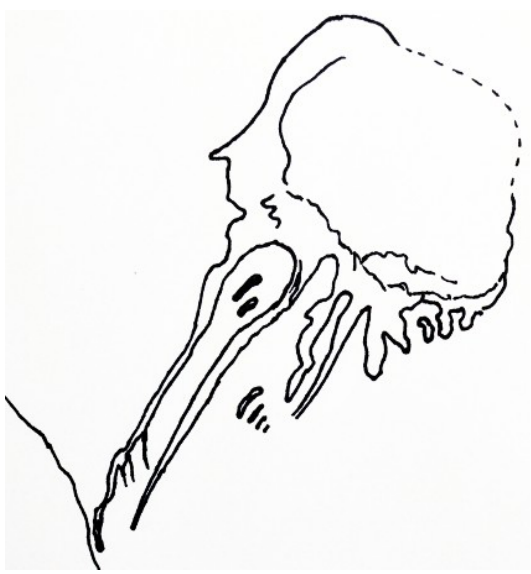
Figure 18. Shenzianyuloma yunnanense nov. gen. nov. sp. IGM 5008. Sketch of gill structure and filaments in previous image. Image Credit: Mark McMenamin.